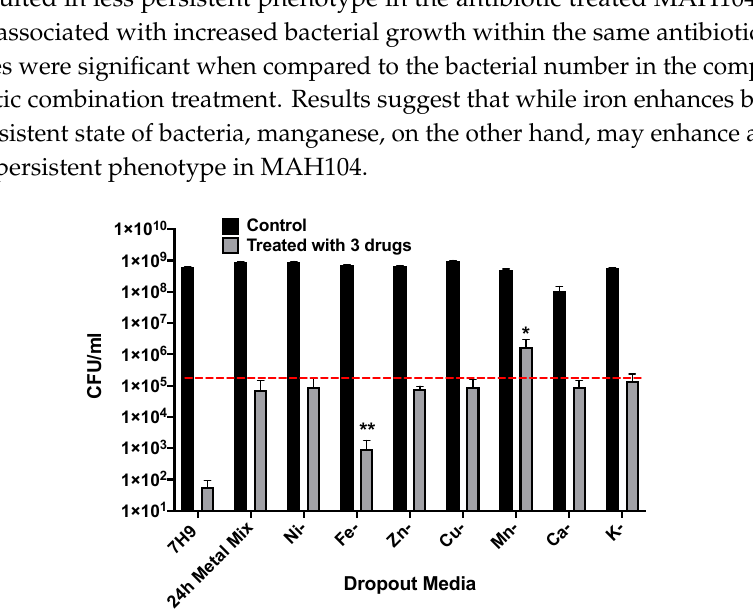
Figure 5. MAH104 growth in the 24 h metal mix missing elements. After initial 24 h incubation of bacteria in the incomplete 24 h metal mix missing single elements, bacteria were subjected to 64 µ g / mL CLA, 64 µ g / mL CIP and 128 µ g / mL RIF combination treatment for additional 24 h at 37 ◦ C under slight agitation. No antibiotic treatment within tested conditions served as a control. The dashed red line represents the viable MAH104 number recovered from the complete metal mix after combination treatment. Data represent the means ± standard deviations (SD) of three independent experiments performed in duplicates. * p < 0.05 and ** p < 0.01 statistical significance for the combinational antibiotic treatment between the incomplete and complete 24 h metal